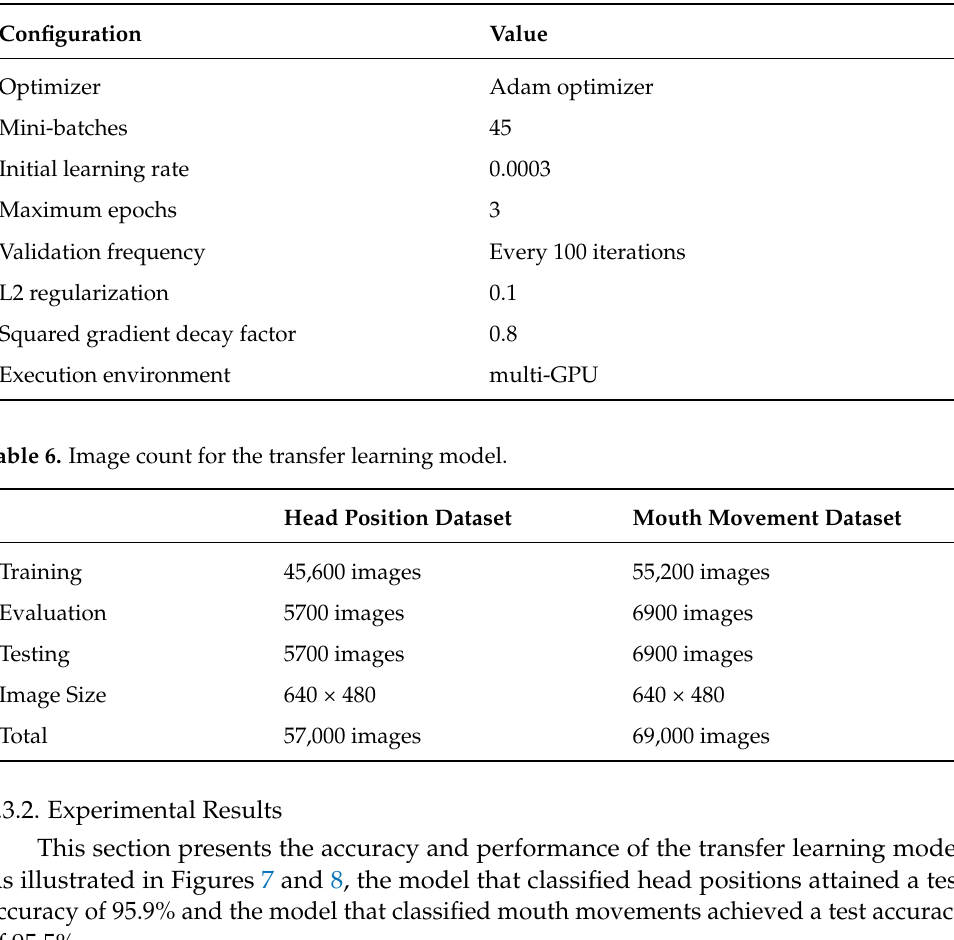
Table 5. Hyperparameter configuration for the transfer learning models.